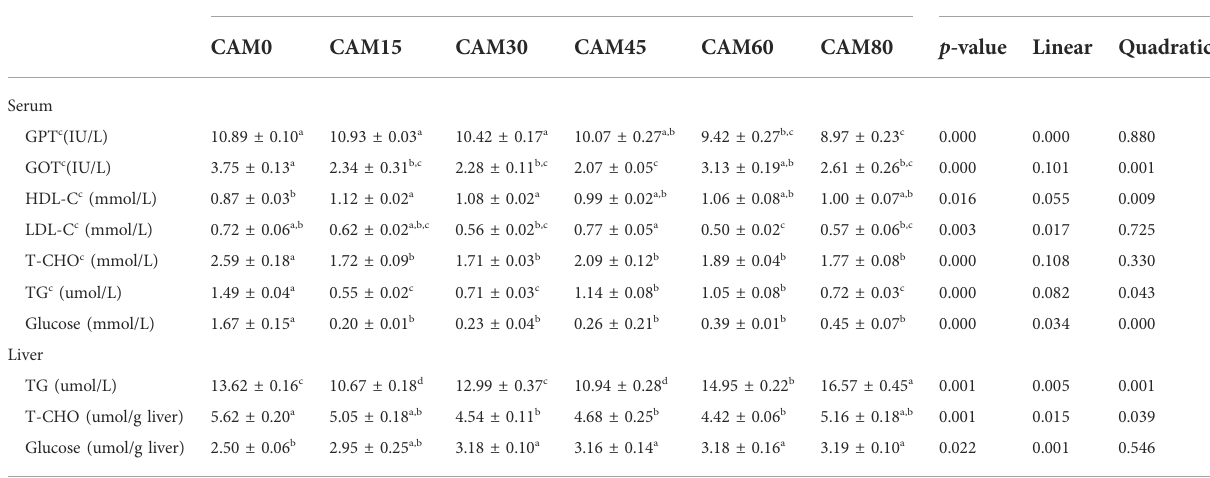
TABLE 10 Serum and hepatic biochemical index (Means ± S.E.M) a .